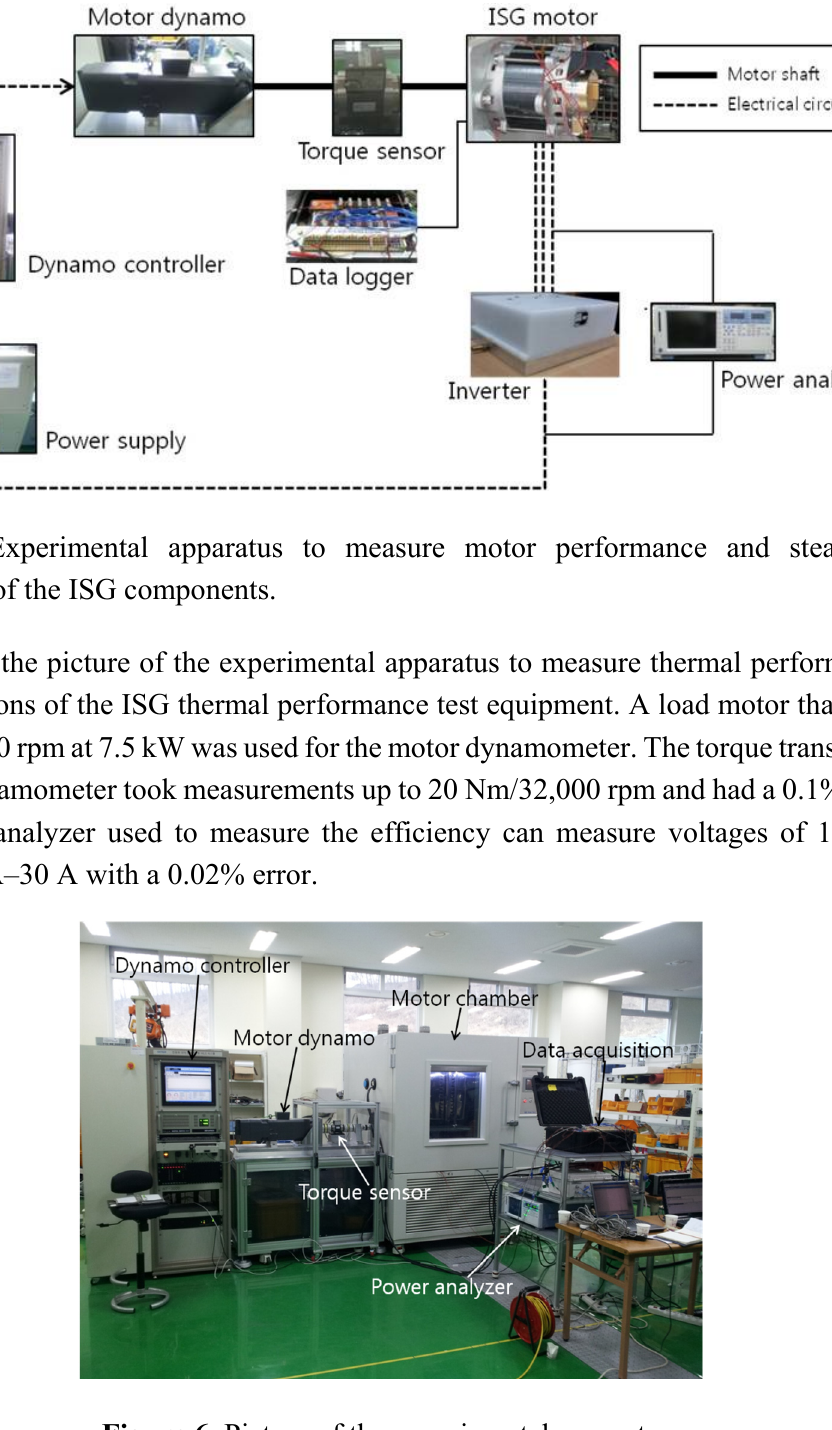
Figure 6. Picture of the experimental